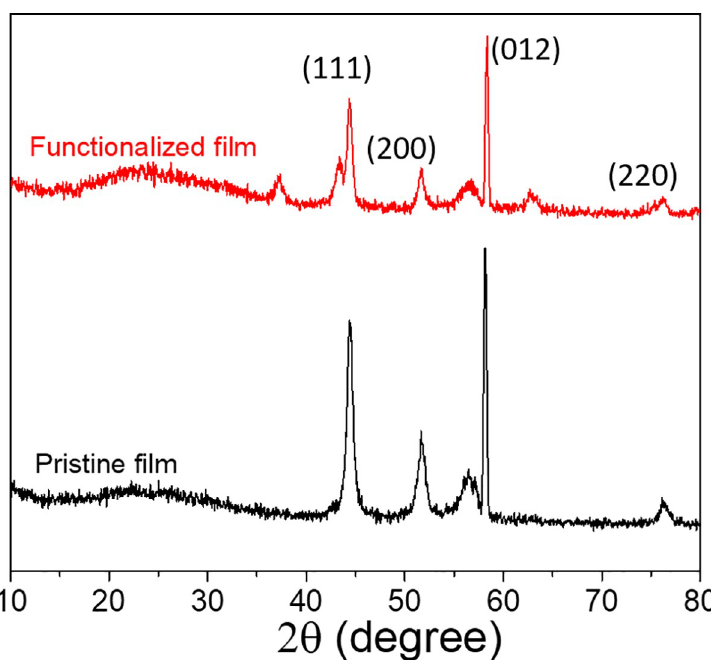
Fig 3. XRD spectra for (black) pristine Ni film and (red) N-functionalized Ni film. The N-functionalized film was treated for 120 s in NH 3